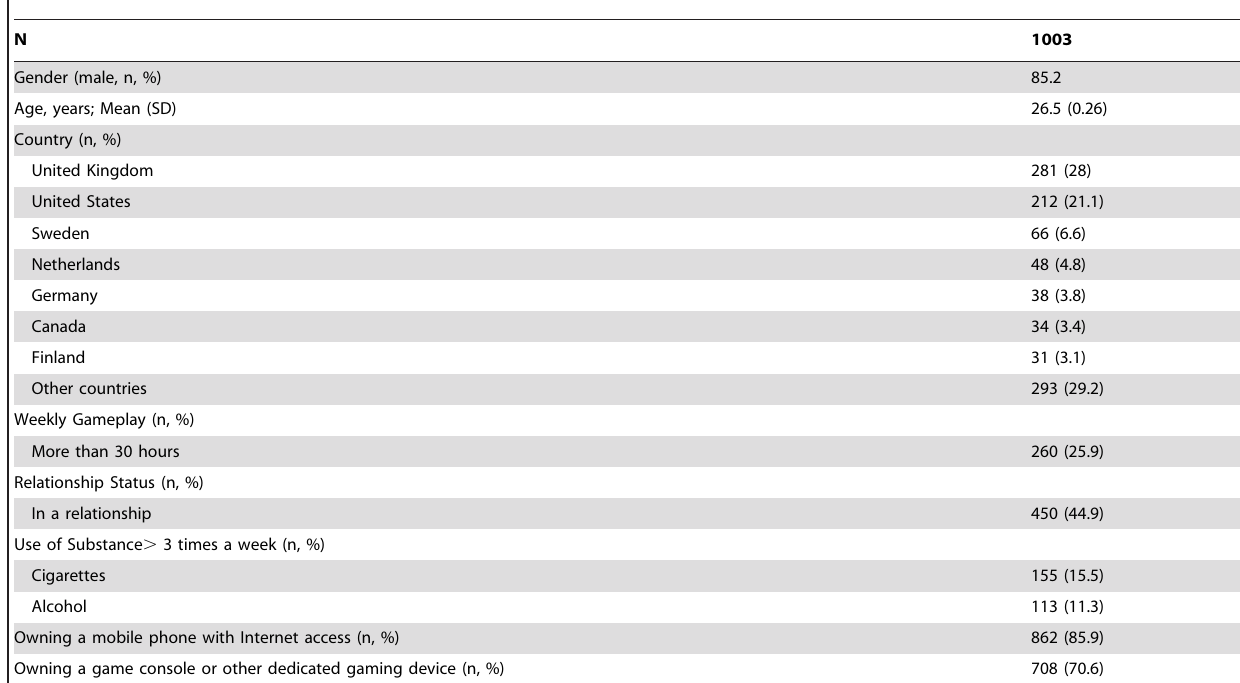
Table 2. Socio-Demographic Characteristics of the